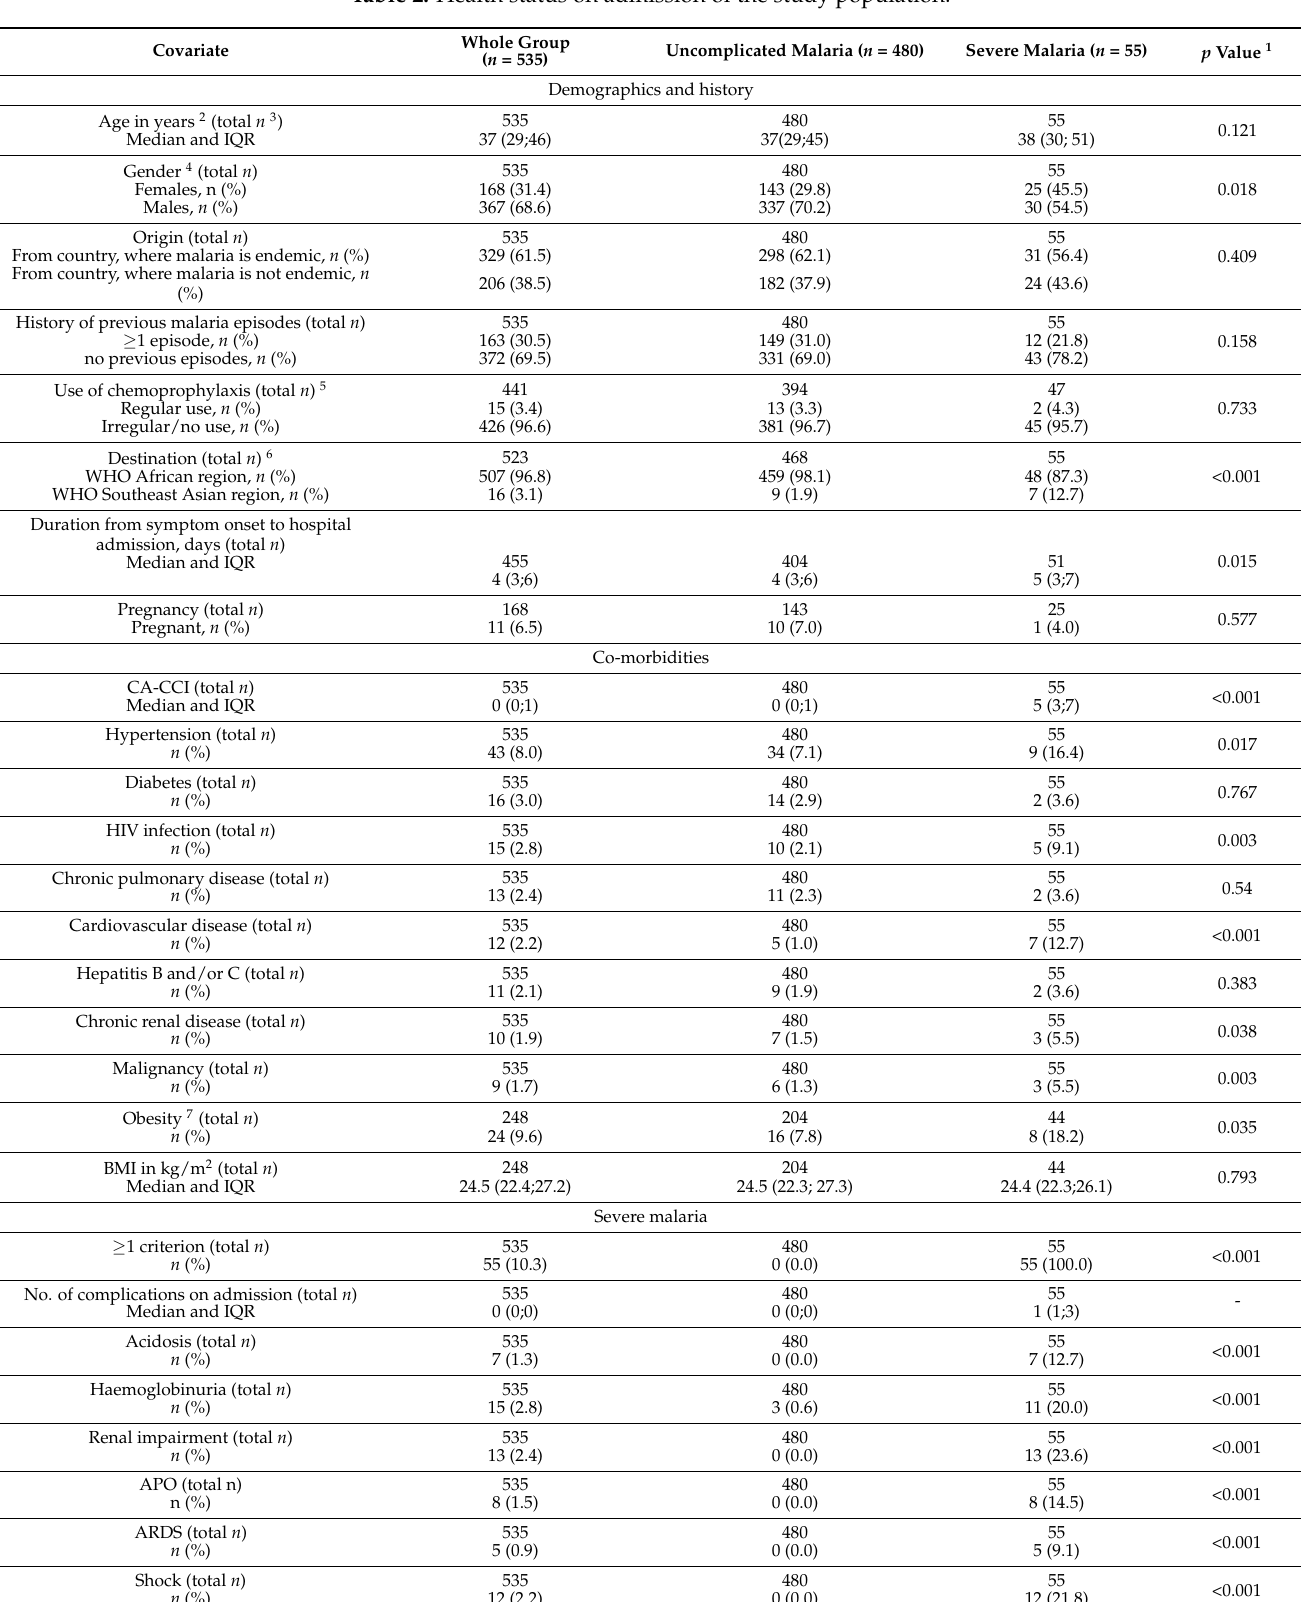
Table 2. Health status on admission of the study